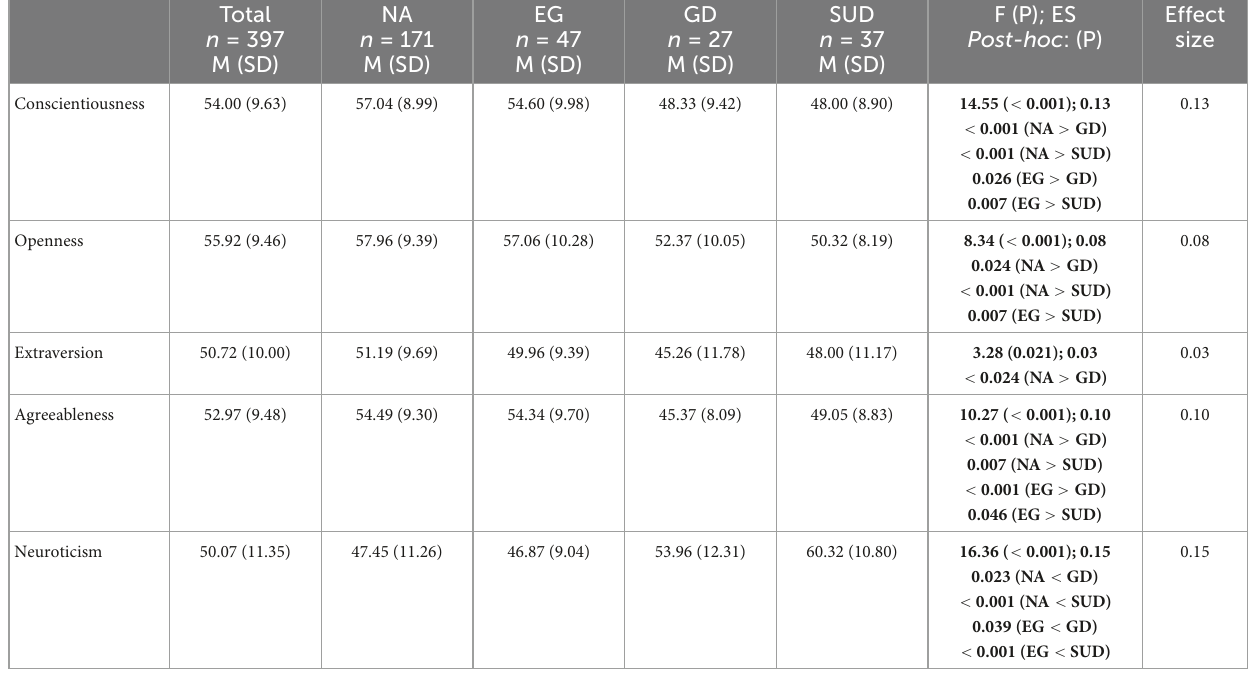
TABLE 3 Descriptive statistics of personality traits of the overall sample and by the no addiction, Excessive Gaming, Gaming Disorder, and Substance Use Disorder groups.